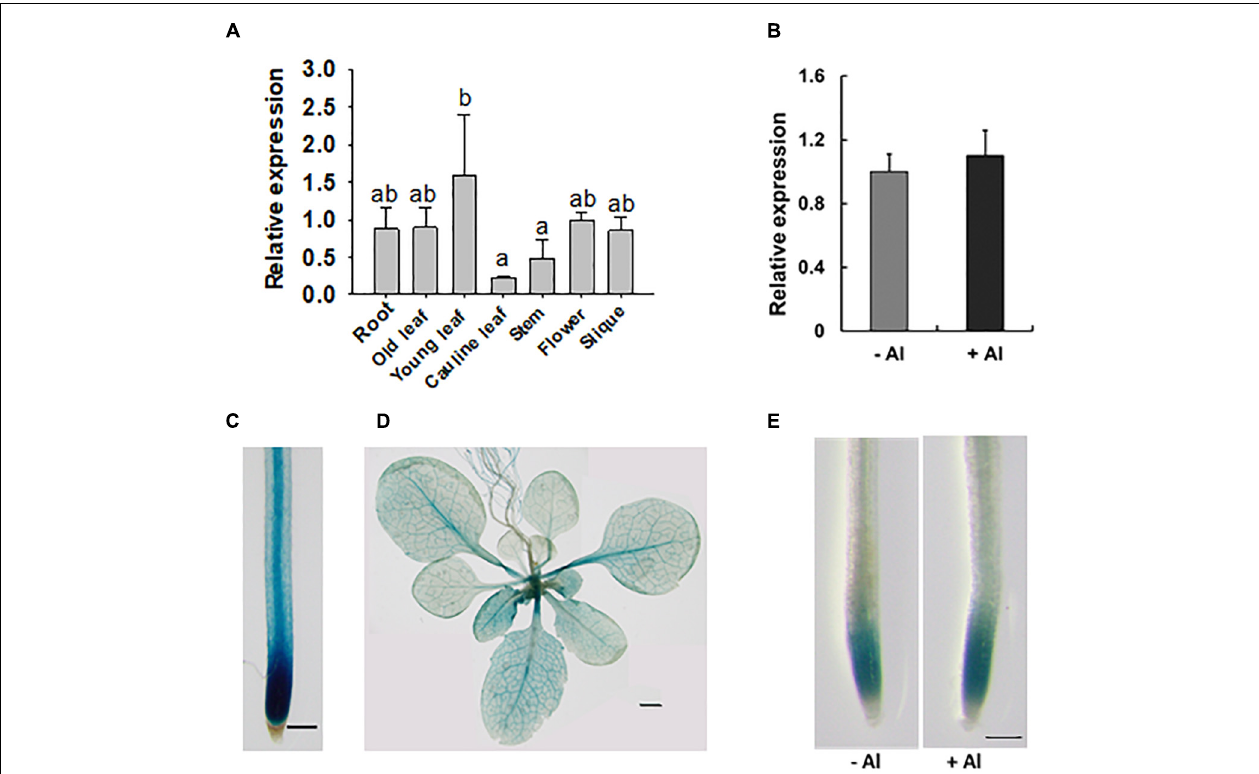
FIGURE 4 | Expression pattern of RAE2. (A) Expression analysis of RAE2 in roots, old and young leaves, cauline leaves, stems, flowers, and siliques. Values are means ± SD ( n = 3). Means with different letters are significantly different ( P < 0.05, ANOVA followed by Tukey’s test). (B) Effect of Al stress on RAE2 expression. Seven-day-old seedlings were exposed to 0 (–Al) or 30 µ M Al (+Al) for 12 h, and the roots were sampled for the expression analysis. Values are means ± SD ( n = 3). (C–E) Detection of GUS activity in pRAE2:GUS transgenic lines. (C) GUS expression is preferentially detected in the root tips and central vascular tissues of mature root zones. Scale bar = 200 µ m. (D) GUS expression in the shoots of three-week-old plants. Scale bar = 1 mm. (E) GUS expression in roots of 7-day-old seedlings in response to 0 (–Al) or 30 µ M Al (+Al) for 12 h. Scale bar = 200 µ